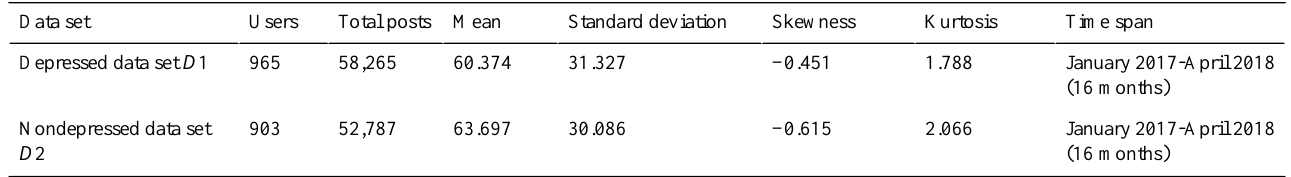
Table 1. Details of the collected data sets from Weibo